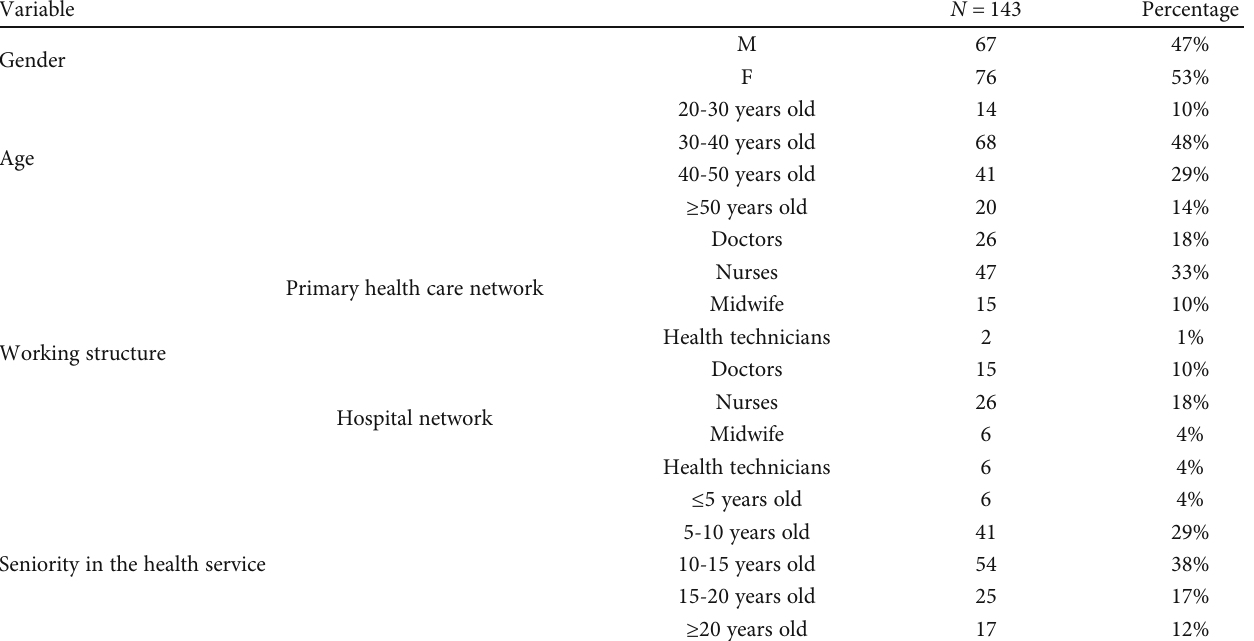
Table 1: The socioprofessional characteristics of the